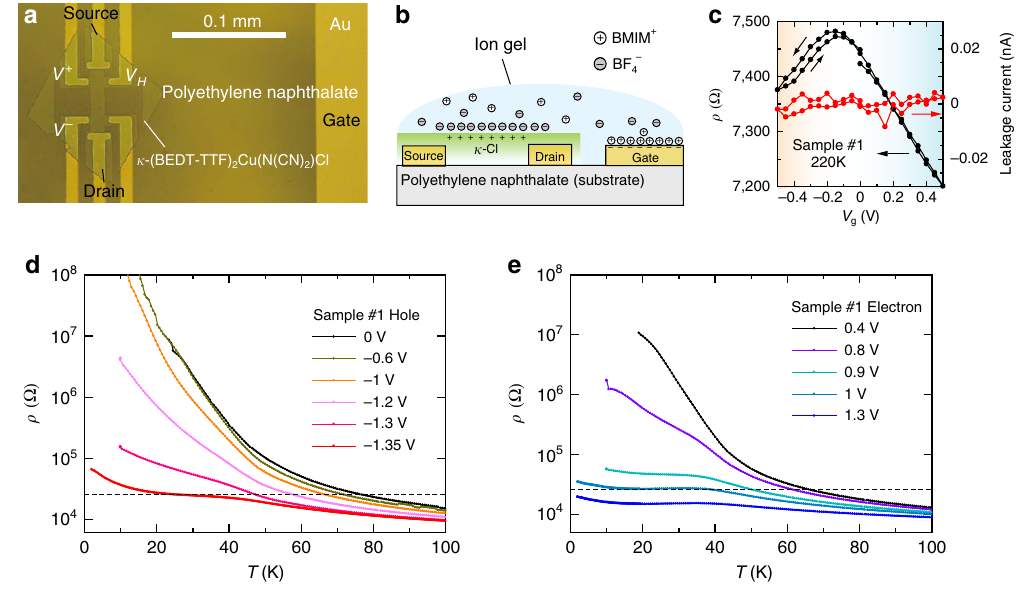
Figure 2 | EDLT device and field effect on sheet resistivity. ( a,b ) Optical top view ( a ) and schematic side view ( b ) of the EDLT device. The k -Cl crystal is shaped into a Hall-bar using a pulsed laser beam. ( c ) Gate voltage dependence of the sheet resistivity at 220K. ( d,e ) Temperature dependence of the sheet resistivity under hole doping ( d ) and electron doping ( e ). The dashed lines denote h / e 2 B 25.8k O . The gate voltage was consecutively applied in the order of appearance, namely: 0, (cid:2) 0.6, (cid:2) 1, (cid:2) 1.2, (cid:2) 1.3 and (cid:2) 1.35V for hole doping and 0.4, 0.8, 0.9, 1 and 1.3V for electron doping.